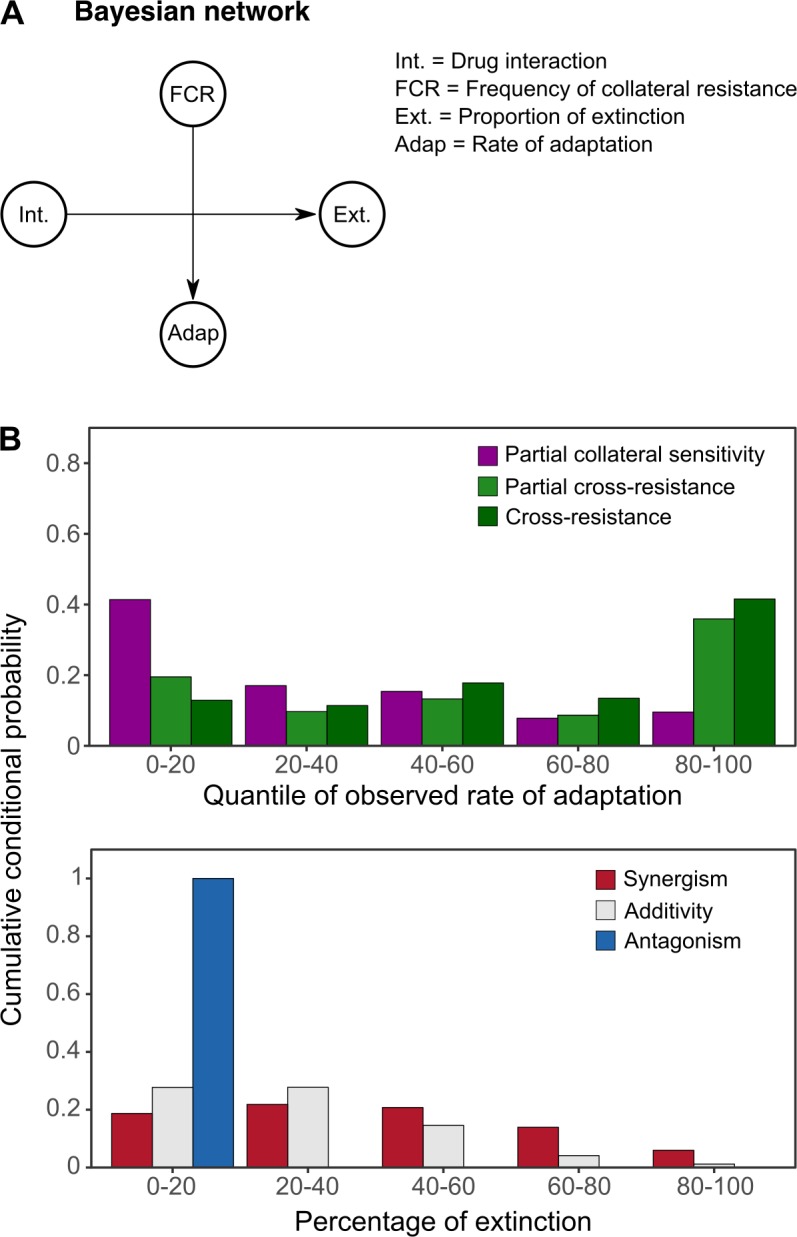
BN analysis of antibiotic resistance evolution under combination therapy.(A) BN obtained from a constraint-based interleaved incremental association algorithm including 4 different random variables: drug interaction types, FCR, proportion of extinctions, and rate of adaptation. (B) Based on the BN, we calculated the conditional probabilities of rate of adaptation for different types of collateral effects (top panel) and extinction frequencies for different antibiotic interaction characteristics (bottom panel). The Bayesian analysis is based on data for drug interaction characteristics (S2 Data), collateral effects [30], and extinction frequencies, and adaptation rates are inferred from growth characteristics during experimental evolution (S4 Data). Adap., rate of adaptation; BN, Bayesian network; Ext., proportion of extinctions; FCR, frequency of collateral resistances; Int., drug interaction types.